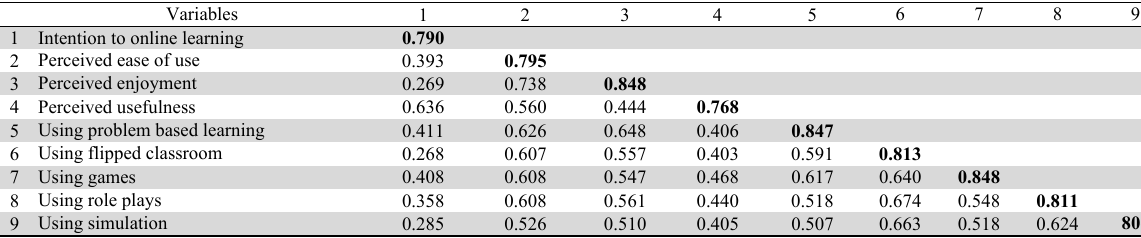
Fornell-Larcker Criterion